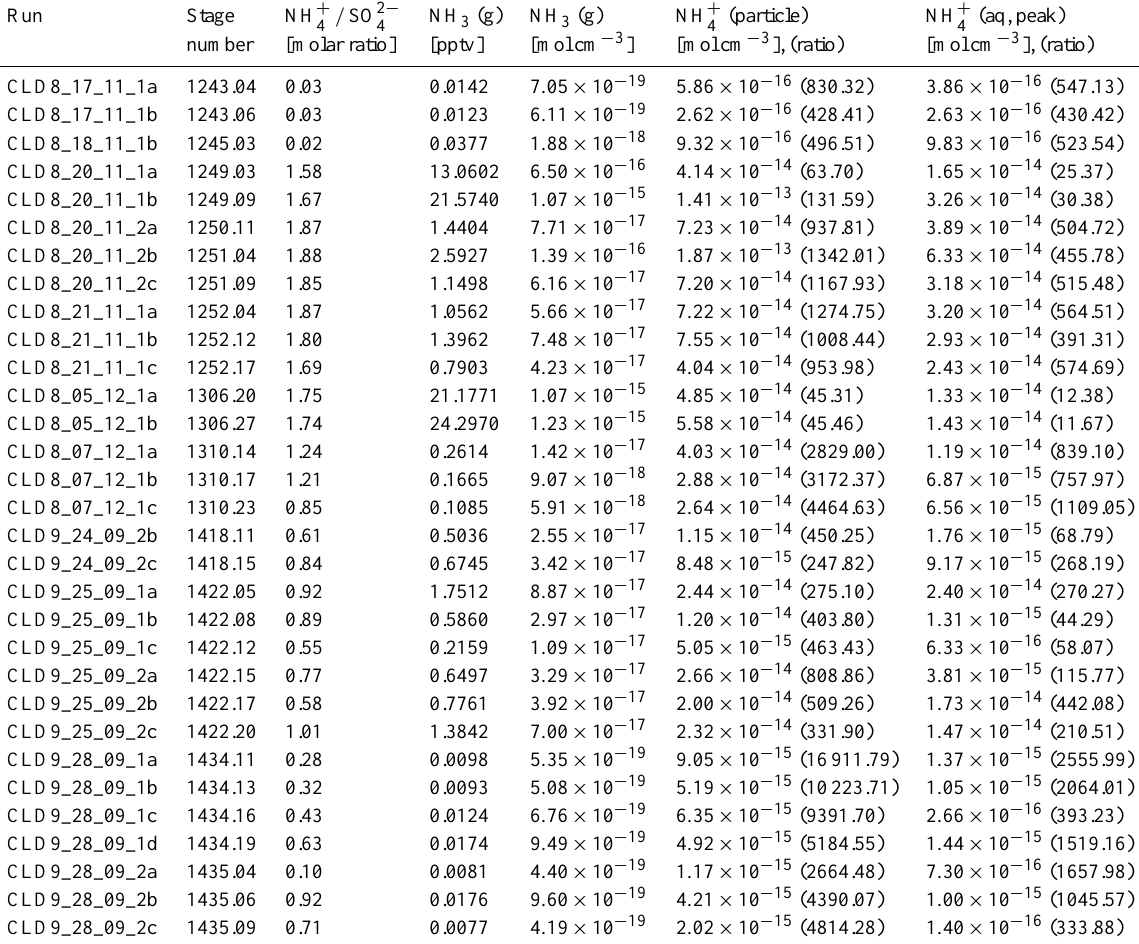
Table 5. Data from the model simulations, showing the gas phase concentration of ammonia, the total particle phase ammonium contained in all particles in one cm 3 of air before cloud formation, and the maximum additional amount of ammonium taken up into all droplets in one cm 3 of air during the cloud formation. Values in brackets indicate the ratio of the number of moles of ammonium contained in the particles or droplets to the gas phase ammonia concentration. The first three columns are reproduced from Table 4, for convenience. Note that the aqueous phase ammonium is in addition to the particle phase ammonium, which is also contained in any droplets that